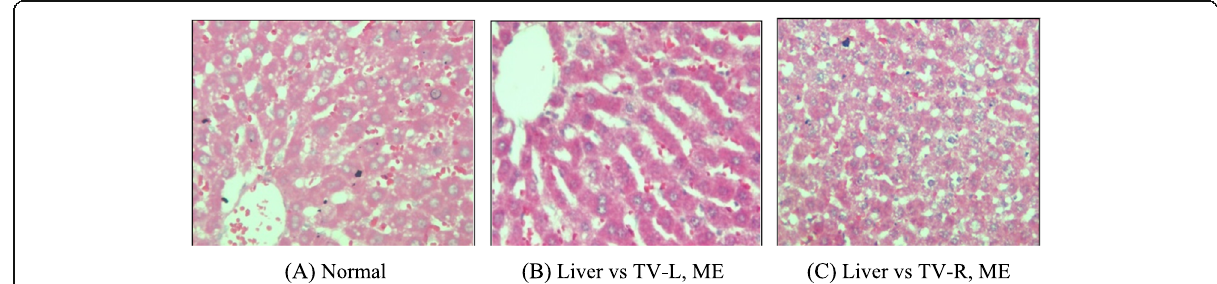
Fig. 3 Histopathological slides of liver section at day 28, (H&E stained under 20x magnification power) where the slide ( a ) represent Liver tissues of control ( b ) Liver tissues treated with TV-L, ME of doses 600, 1200 and 2000 mg/kg ( c ) Liver tissues treated with TV-R, ME of doses 600, 1200 and 2000 mg/kg body